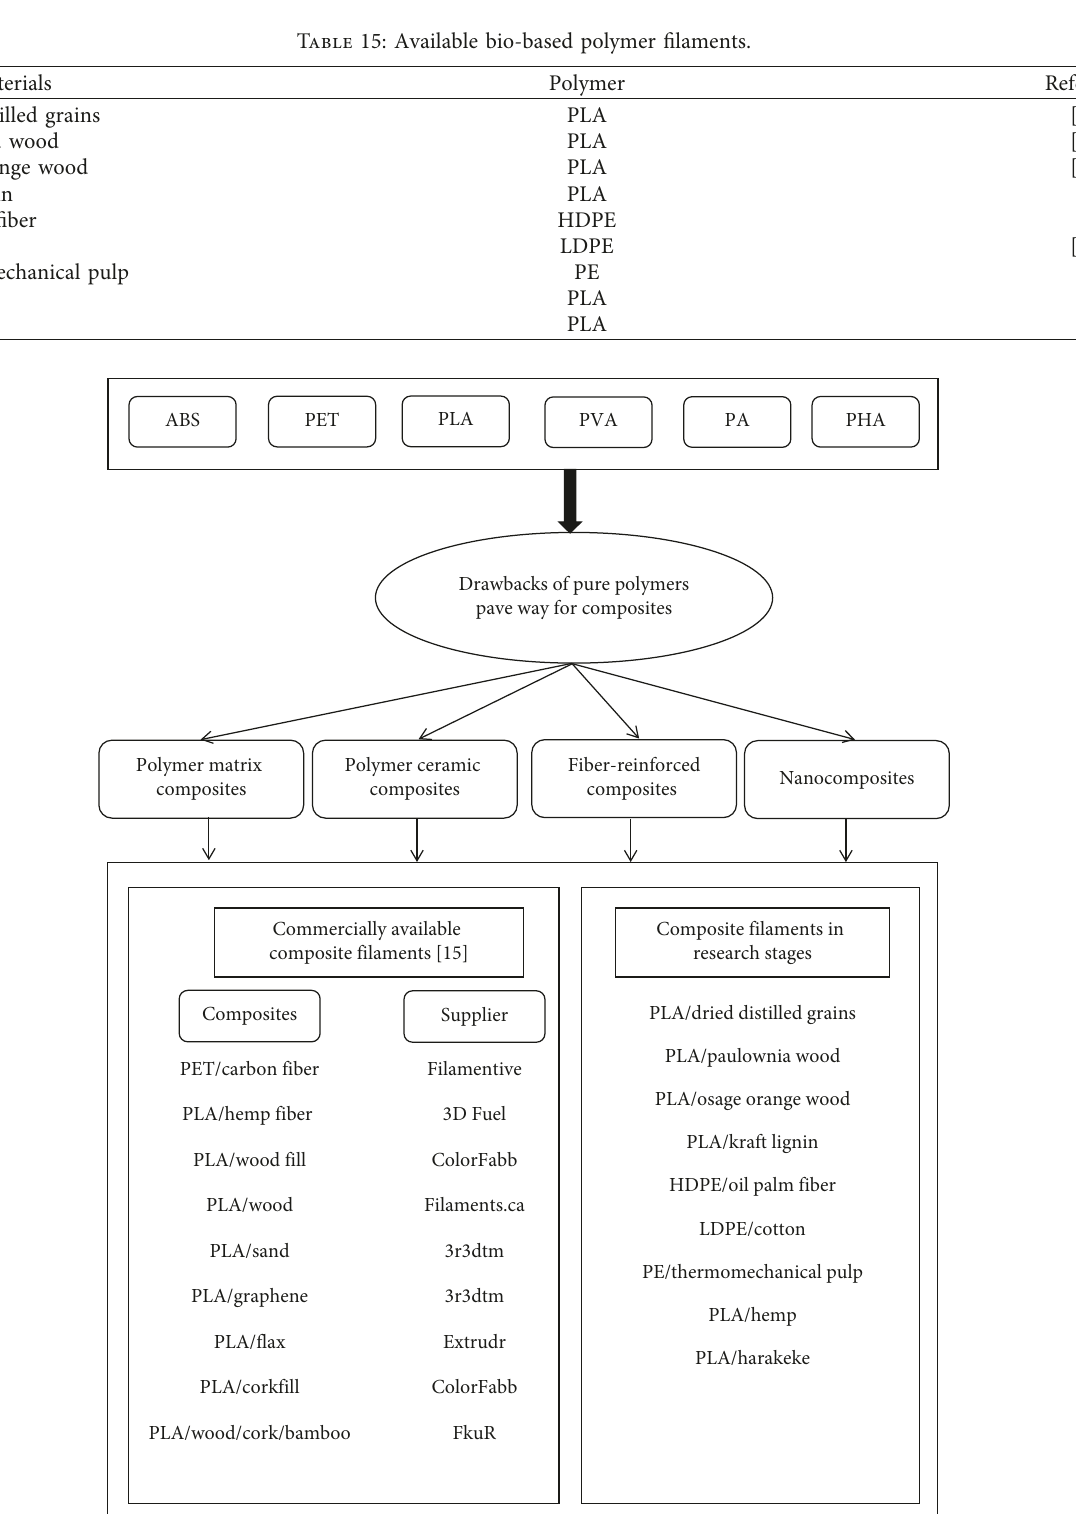
Figure 3: Overall list of materials used in FDM